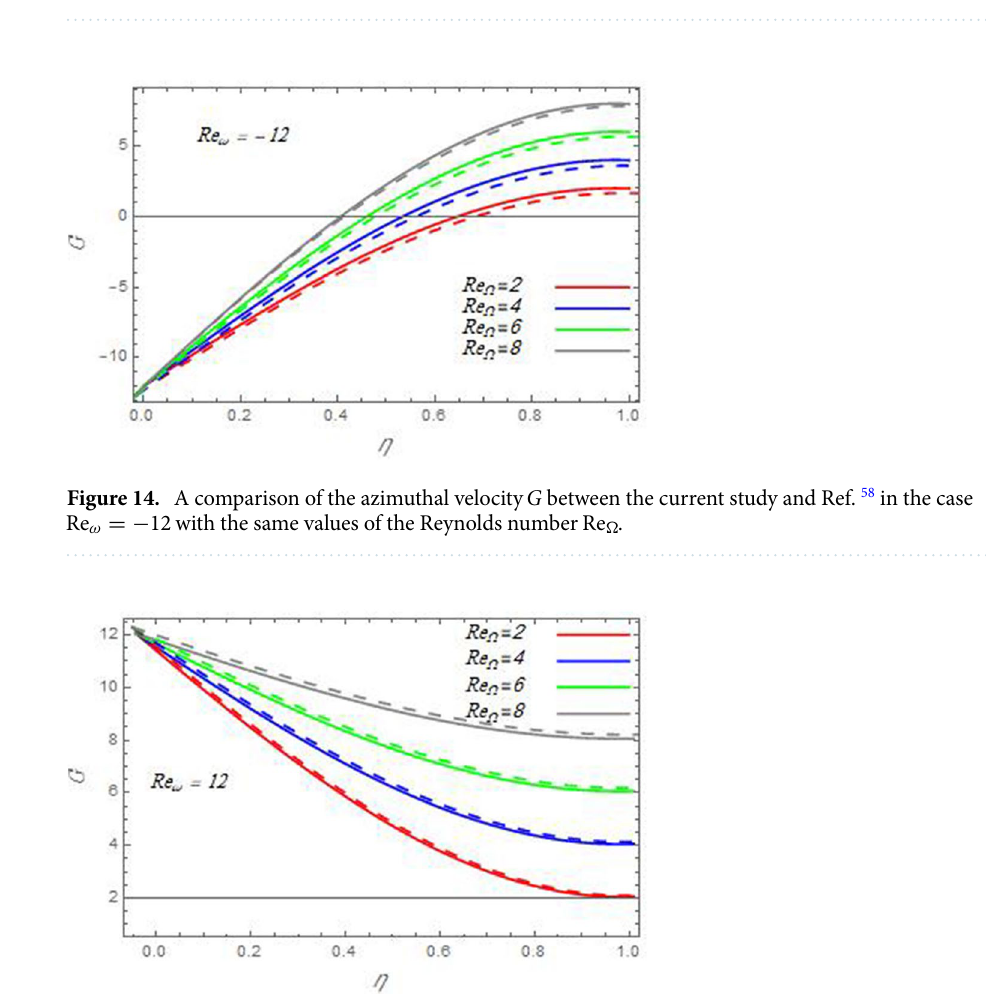
Figure 13. The azimuthal velocity G is plotted versus the axial variable η in the case of stationary cone to depict the effect of the magnetic parameter M .